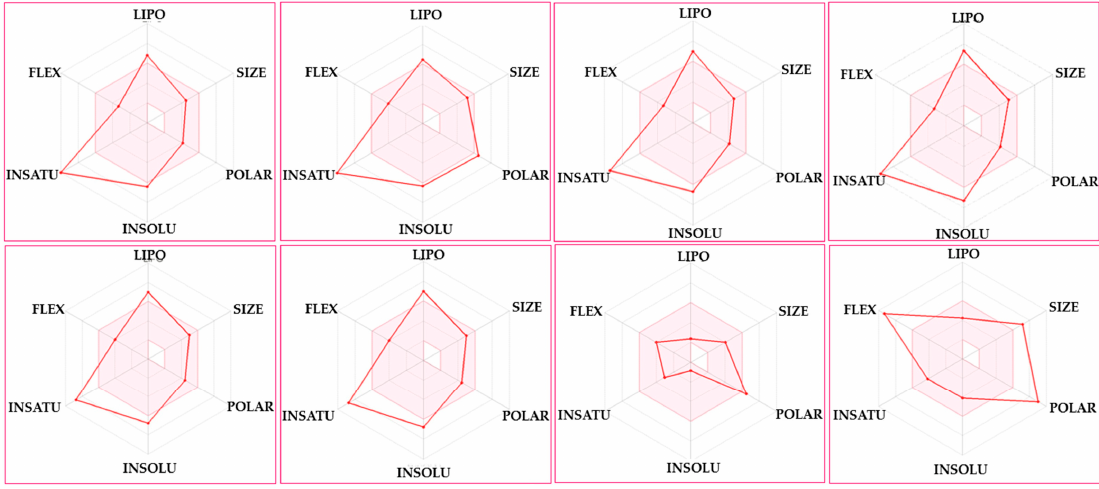
Figure 8. Bioavailability radar for ligands 3a–f and the approved drugs Molnupiravir and Remdesivir. Importantly, when applying the Lipinski rule of five (ROF5), i.e., a molecular weight of <500 g/mol, a logP value of <5, the number of H-bond donors of <5, the number of H-bond acceptors of <10 [42], and an additional rule proposed by Veber concerning the number of the rotatable bonds of <10 [43], all the six ligands were likely to be bioavailable as drugs. However, some were better than others when summing oral bioavailability rules, toxicity, and docking. For example, 3f had the highest binding affinity when docked to the M pro of SARS-CoV-2, and it also met the ROF5. This can also be applied to the other ligands; thus, the poorest ligand was 3c , with the lowest binding affinity in its docking and the least extent to which it met the